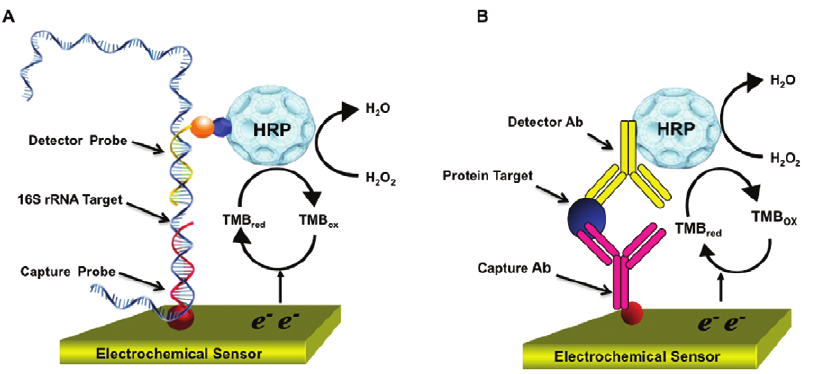
Figure 1. Schematics of urine-based diagnostics for electrochemical biosensor detection of nucleic acids and proteins. (A) Schematic of pathogen identification based on sandwich hybridization of bacterial 16S rRNA with capture and detector oligonucleotide probes; (B) Schematic of immunoassay based on sandwich detection host urinary protein with capture and detector antibodies. The two assays share similar assay parameters, including surface functionalization with biotinylated capture probes/antibodies, probe-target binding at 37 u C, and amperometric detection using horseradish peroxidase (HRP) as the signaling enzyme [7,8].